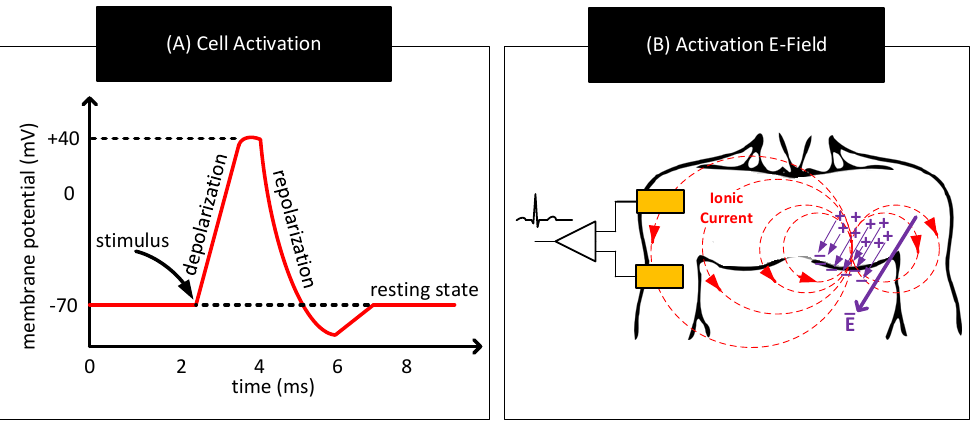
Figure 12. ( A ) Representative waveform showing temporal variations in the cell’s membrane poten- tial when an external stimulus activates the cell. ( B ) Formation of an electric dipole, electric fields, and ionic currents in response to bodily activities triggering synchronous activation of a large number of